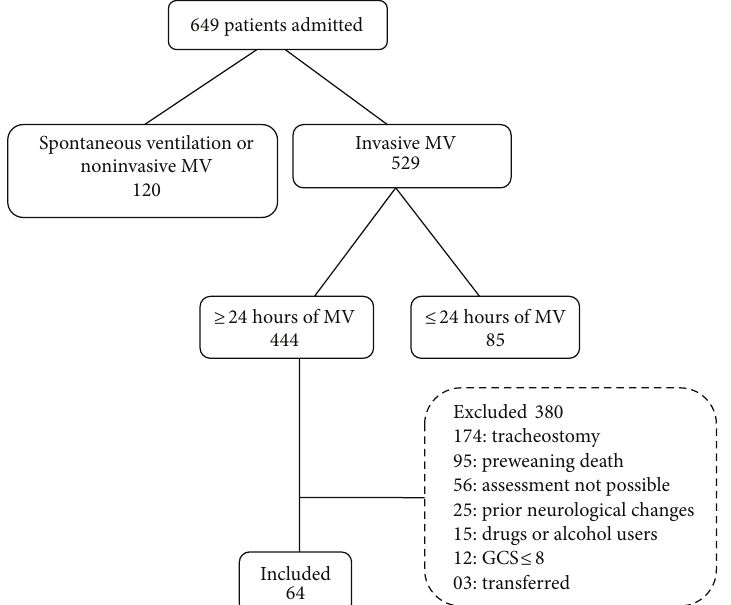
Figure 1: Eligible patients included and excluded from the study. MV: mechanical ventilation; GCS: Glasgow Coma Scale.